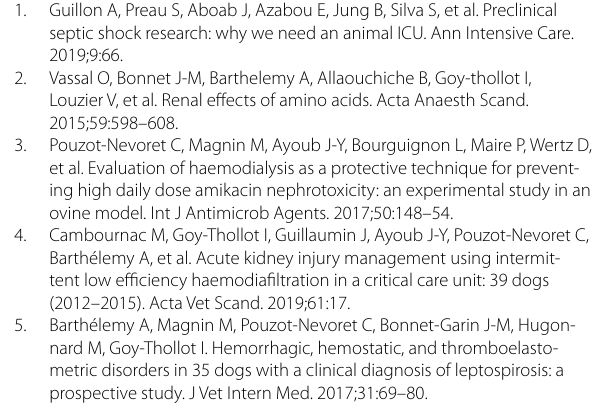
Fig. 2 Example of a dog treated with high‑flow nasal cannula because of septic respiratory